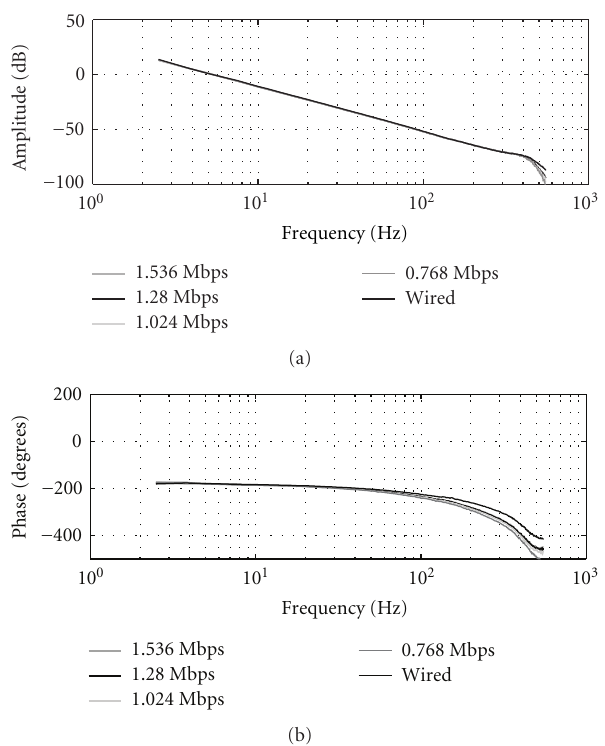
Figure 9: Measured transfer functions of rotary motor with wireless link at di ff erent data rates.